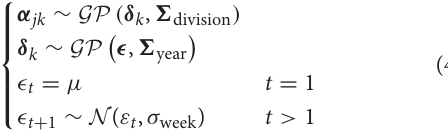
interaction between week, year, and division. The joint model defined in Equations (1), (2a), and (3) includes a time-varying component at the week-scale with interaction with year and